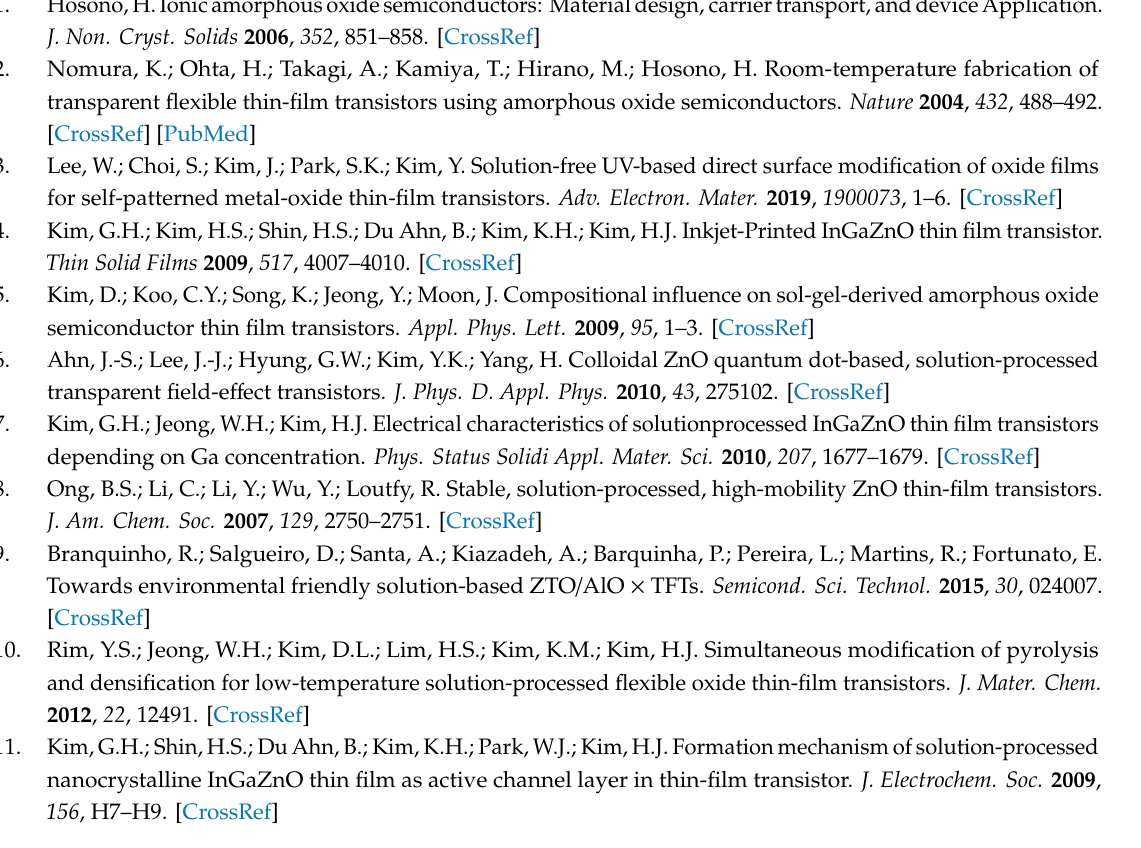
spectra of IGZO solutions, Table S7: Viscosity of combustion IGZO precursor solutions with di ff erent In:Ga:Zn ratio, Table S8: Combustion IGZO films’ thickness measured by spectroscopic ellipsometry, Table S9: Bandgap energy (Eg) of combustion IGZO thin films determined by spectroscopic ellipsometry, Figure S2: Transmittance measurements of combustion of 1-, 2- and 3-layer IGZO 3:1:1, Figure S3: AFM deflection images (2 × 2 µ m2) of 1-, 2- and 3-layer IGZO thin films with di ff erent In:Ga:Zn ratio (a) 1:1:1, (b) 2:1:2, (c) 2:1:1 and d) 3:1:1, Figure S4: Deconvoluted O 1s spectra of the XPS depth profile after 0 s, 100 s and 200 s argon cluster etching, Figure S5: Transfer characteristics of 3-layer 3:1:1 IGZO TFTs produced using IGZO precursor solutions with and without urea as fuel, Figure S6: Capacitance-frequency measurements of Si / solution-based AlOx / Al MIS device, Figure S7: Transfer characteristics of 3-layer IGZO (3:1:1) / AlOx TFT when a positive gate bias stress (PBS) of 0.5 MV · cm − 1 is applied over